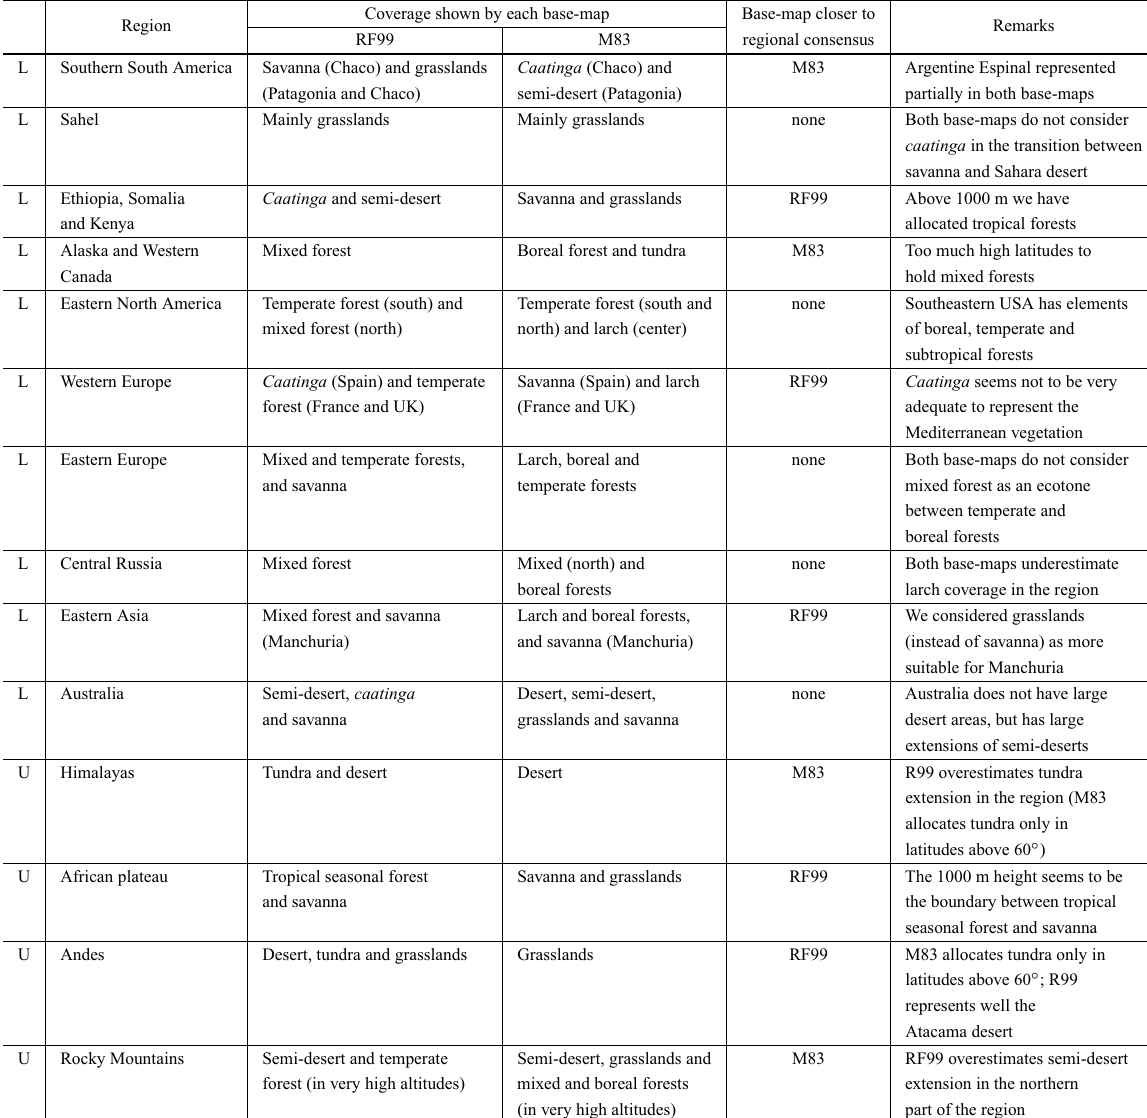
The main non-consensus regions between M83 and RF99 maps. In the first column, L refers to lowland regions (elevation < 1000 m), and U to upland regions (elevation > 1000 m). Caatinga refers to tropical shrubland (type 8 of